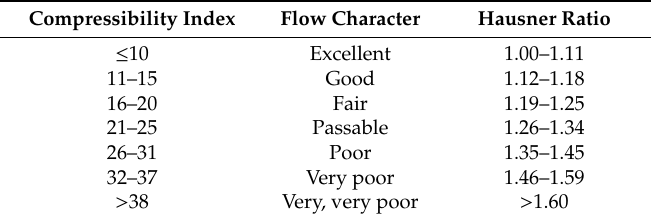
Table 6. U.S Pharmacopeia Scale of flowability (1174 powder flow)